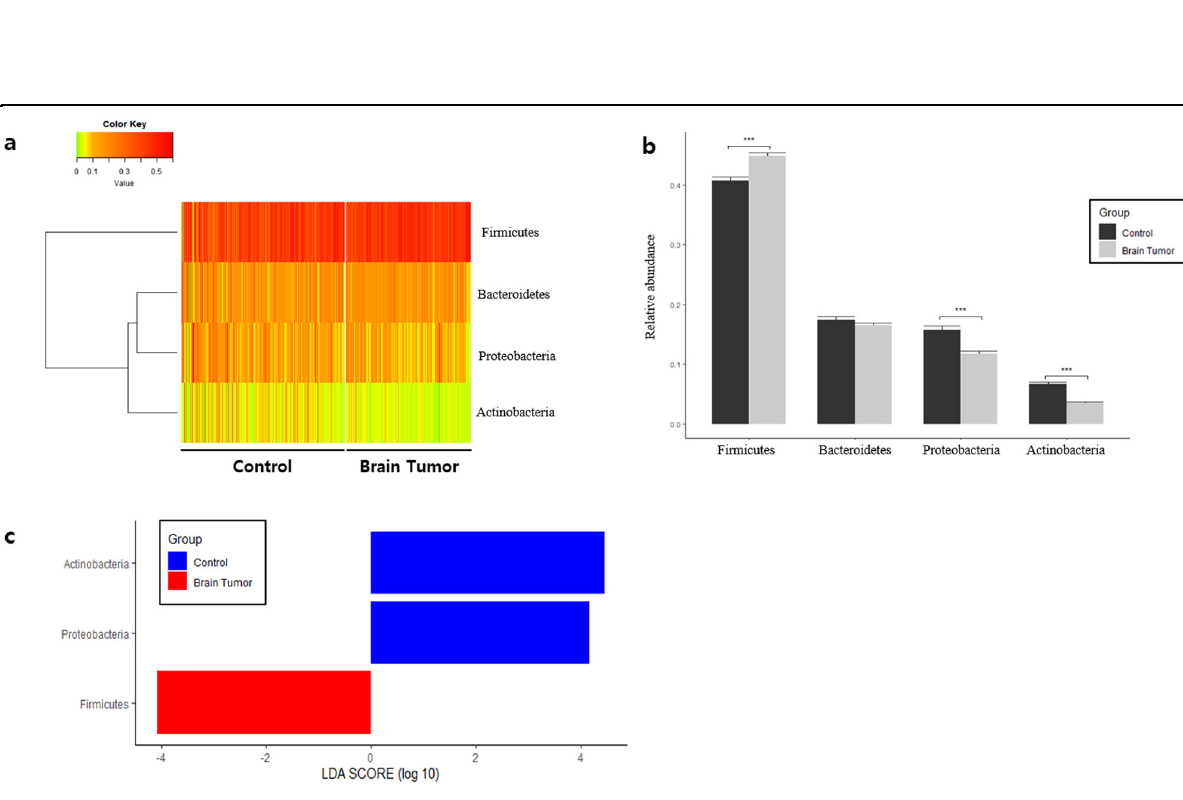
Fig. 2 Differences in microbiome abundance between healthy control (HC) subjects and brain tumor (BT) patients in serum at the phylum level. a Heatmap of serum microbial EV abundance. b Major bacterial EVs and signi fi cant difference between the HC and BT groups by t -test (>1% in any group). c Signi fi cantly different bacterial EVs determined through LEfSe analysis (>4 log(LDA